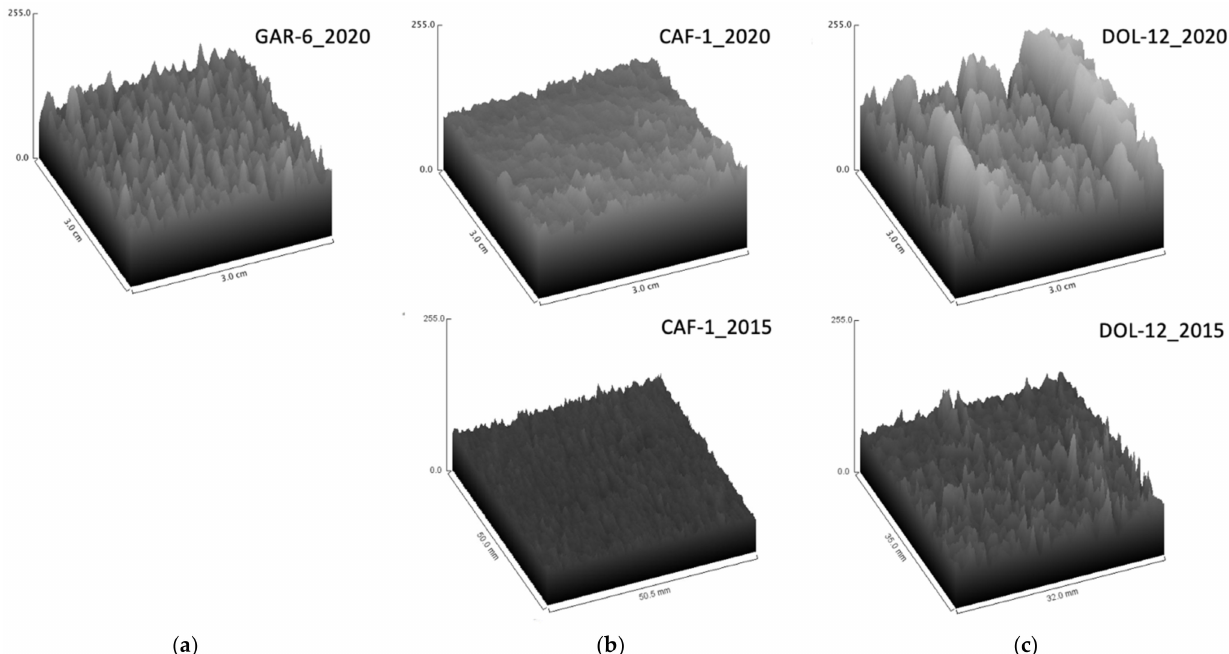
Figure 7. Significant examples of surface plots collected in ( a ) Garzoni Palace; ( b ) Ca’ Foscari; ( c ) Ca’ Dolfin in 2020 ( above ), and in 2015 ( below